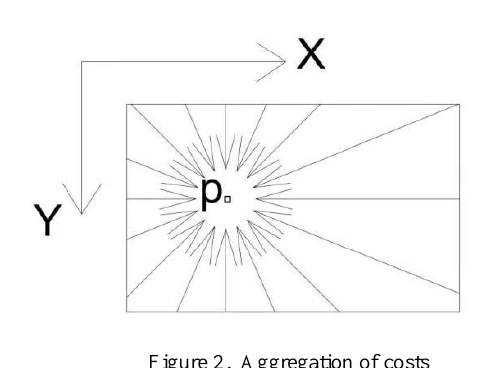
Figure 2. Aggregation of costs